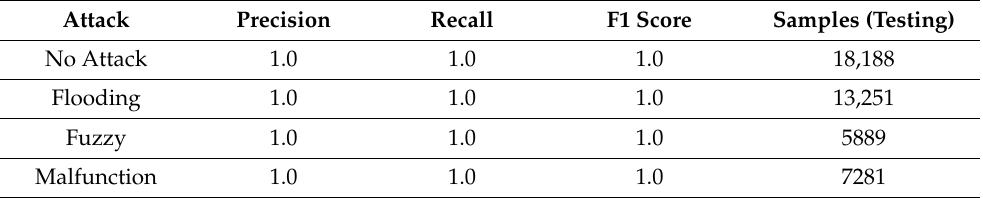
Figure 10. Confusion Matrix of DT (Dataset 2). Table 7. Detection performance of flooding, fuzzy, malfunction, and attack-free for DT (Dataset 2).